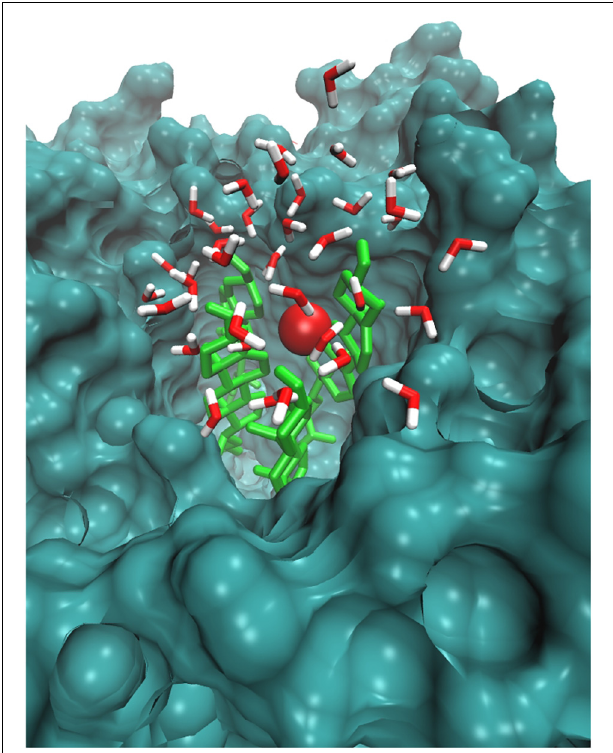
FIGURE 7 | Simulation snapshot showing O 2 species in the headgroups regions at 25.4265 ns. The O 2 species is presented according to element color. The cholesterol is shown in light green color. The rest of the bilayer is shown as surface representation with dark green color. The water molecules within 8 Å are shown with the default color.